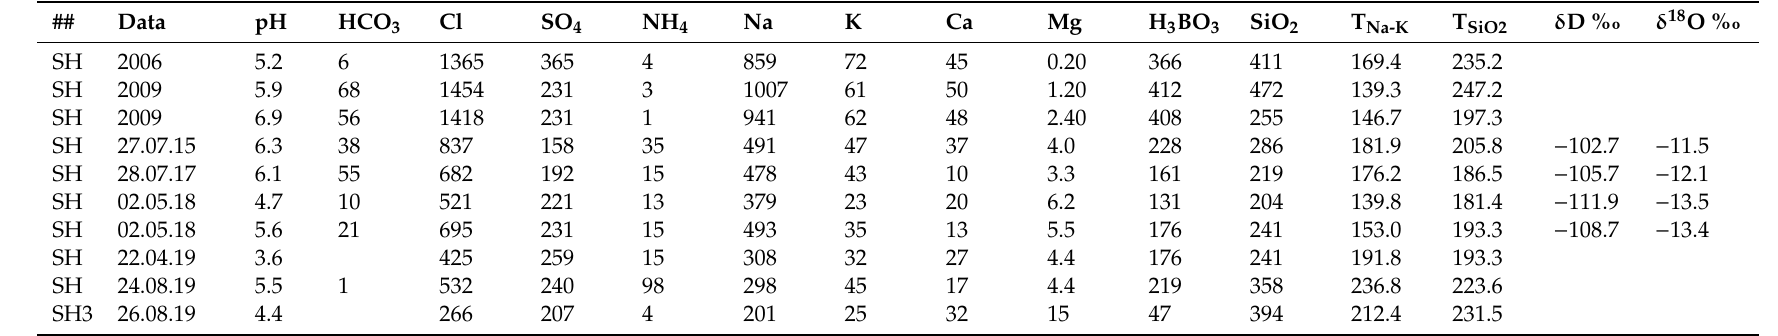
Table 1. Chemical parameters of the Shaman geyser water (in ppm). Chemical composition of pre-Shaman hot spring (2006), sampling in 2006–2009 was performed by G.A. Karpov, and sampling in 2015–2019 was performed by A.V. Kiryukhin. Chemical analysis was performed in Central Chemical Lab Institute of Volcanology & Seismology Far East Branch Rassia Academy of Scieces (IVS FEB RAS). Isotope analysis was performed by P.O. Voronin using LGR IWA 35EP. Notes: